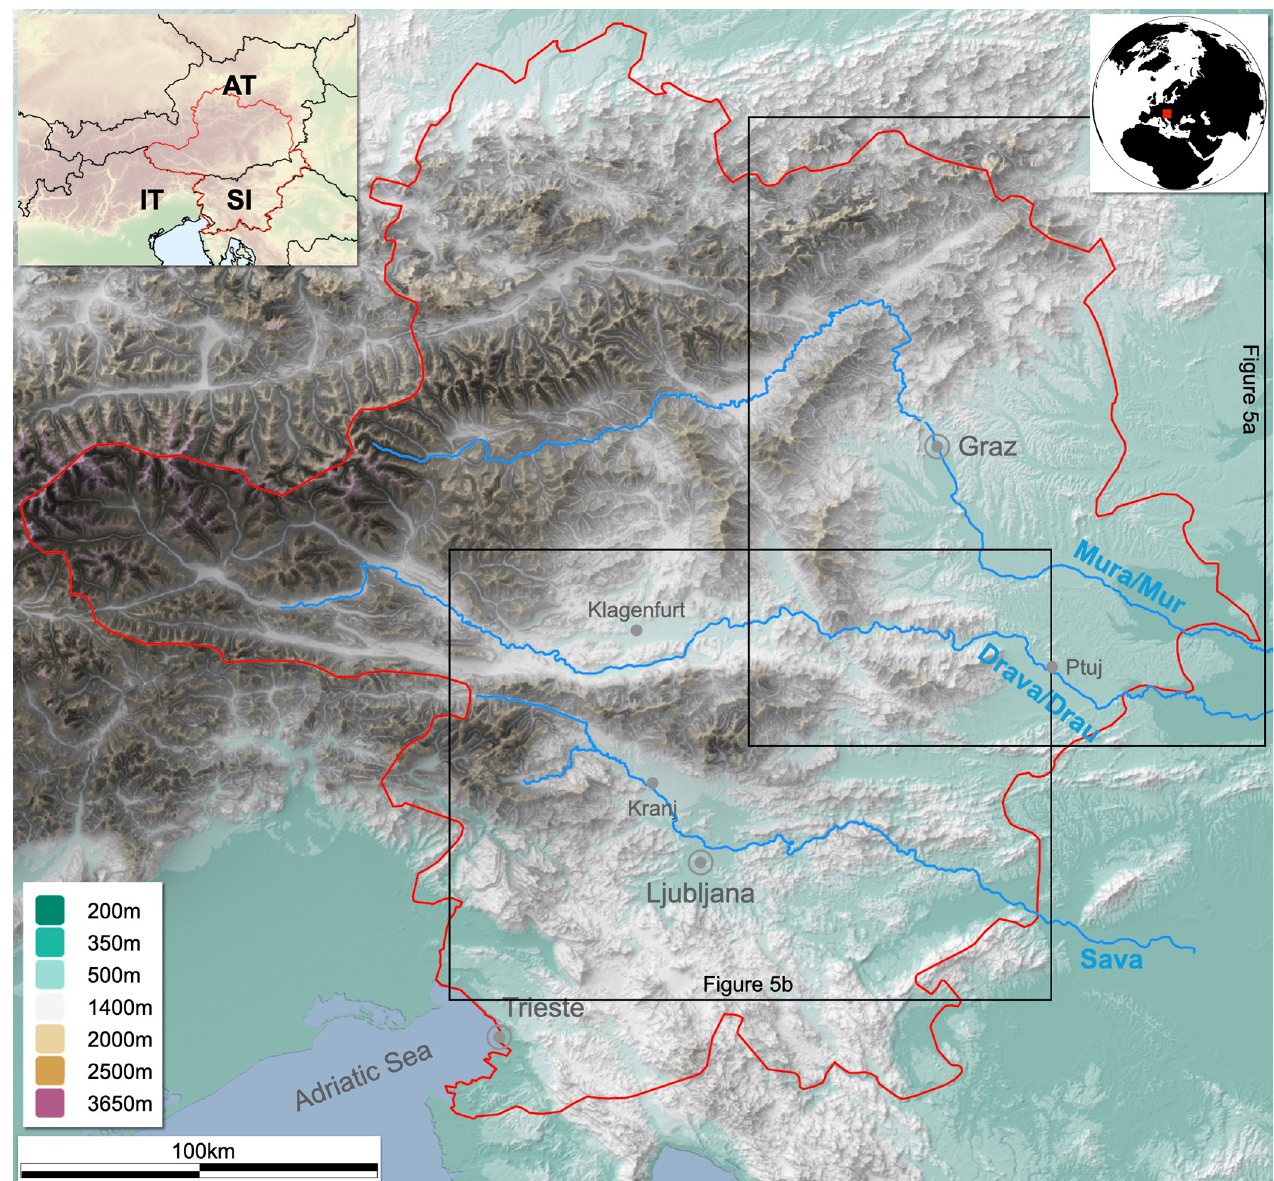
Fig 1. Map of the study area (upper left corner Lat. 48.22015, Lon. 12.35667; lower right corner Lat. 45.29785, Lon. 16.41784). The study area is marked in red and locations of Fig 5A and 5B in black (authors E.L. and B.S ˇ ; contains information from OpenStreetMap and OpenStreetMap Foundation, which is made available under the Open Database License; contains information adapted and modified from Copernicus Land Monitoring Service product EU-DEM25, which was produced with funding by the European Union).